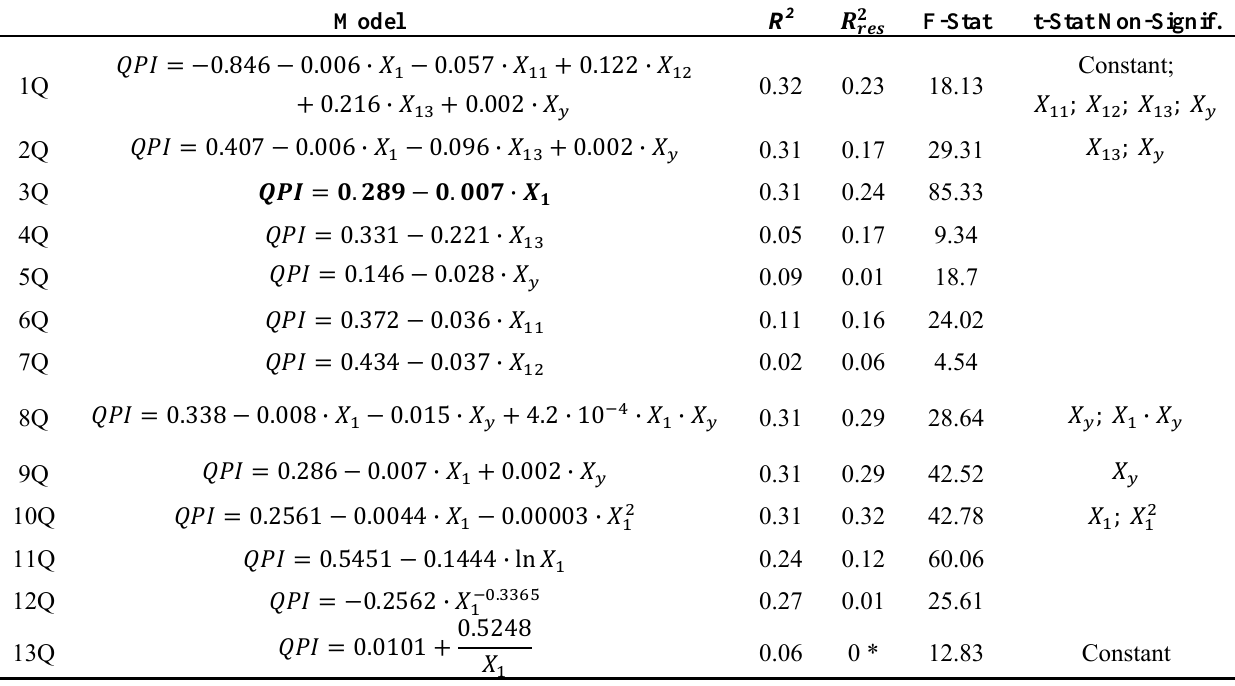
Table 9. Summary table for QPI prediction